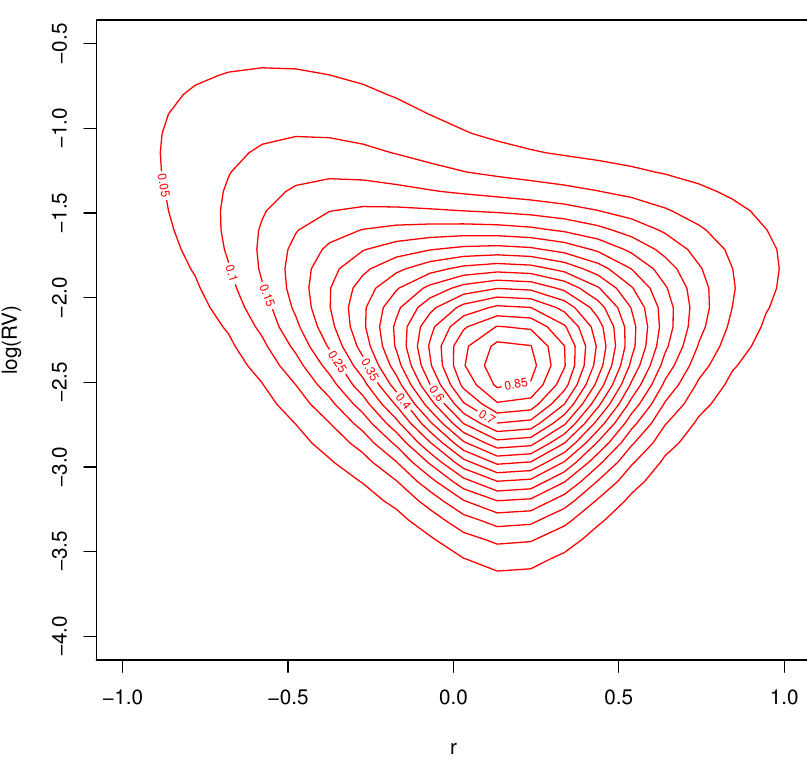
Figure 15. Predictive density for r ,log ( RV ) for average volatility I t − 1 , t = 1996 : 2.